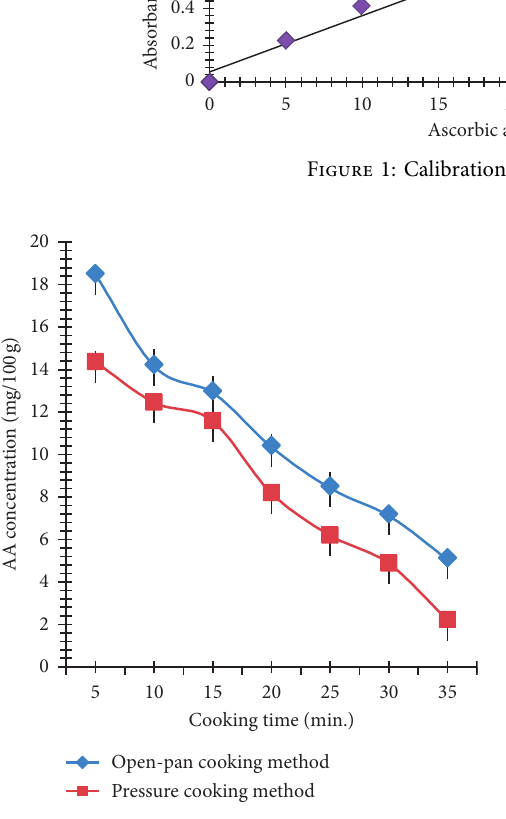
Figure 2: Effect of cooking methods on ascorbic acid loss of cabbage (error bars represent SE of the means).